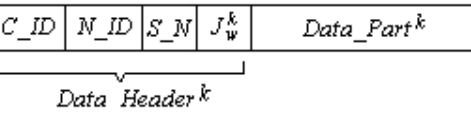
Figure 2. Data package content.